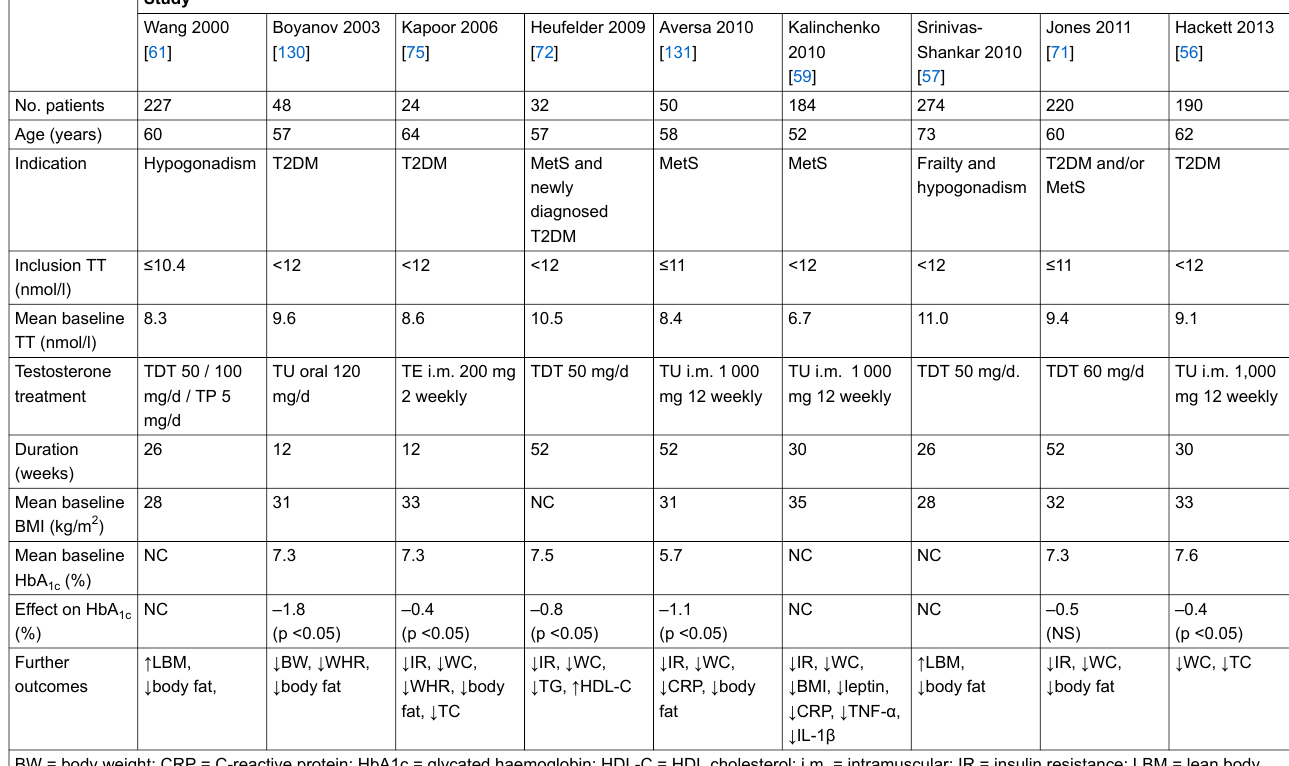
Table 1: Most important randomised controlled trials on metabolic outcomes of testosterone replacement